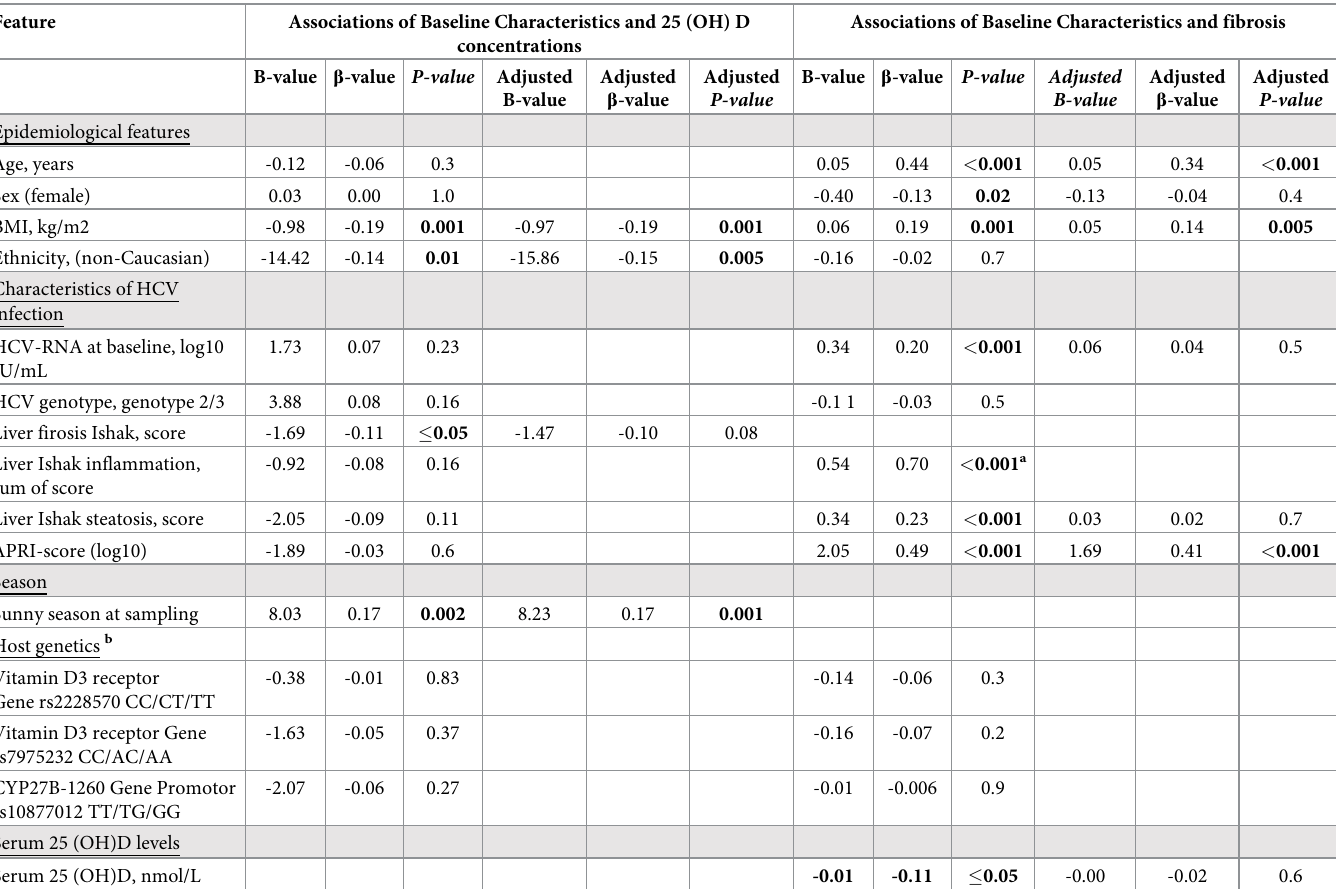
Table 2. Associations of baseline characteristics with 25 (OH) D concentrations and fibrosis.